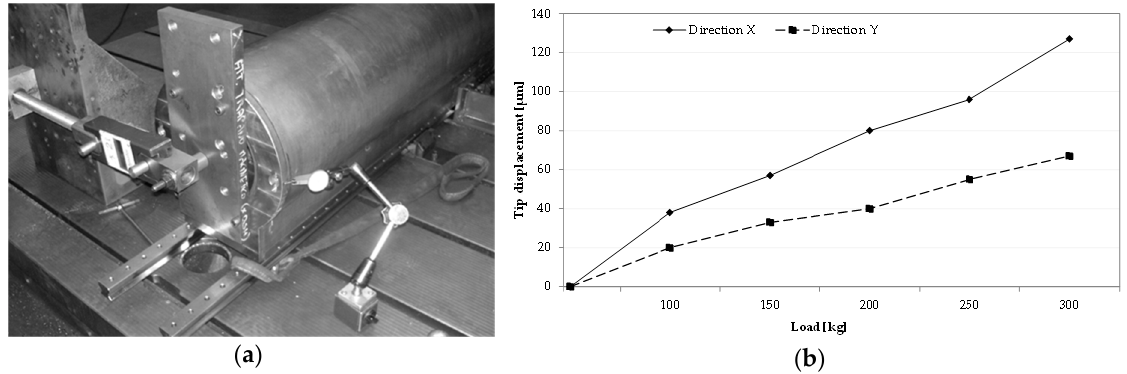
Figure 5. Test bench setup overview ( a ) and the experimental results of the statistic tests performed on a ram ( b